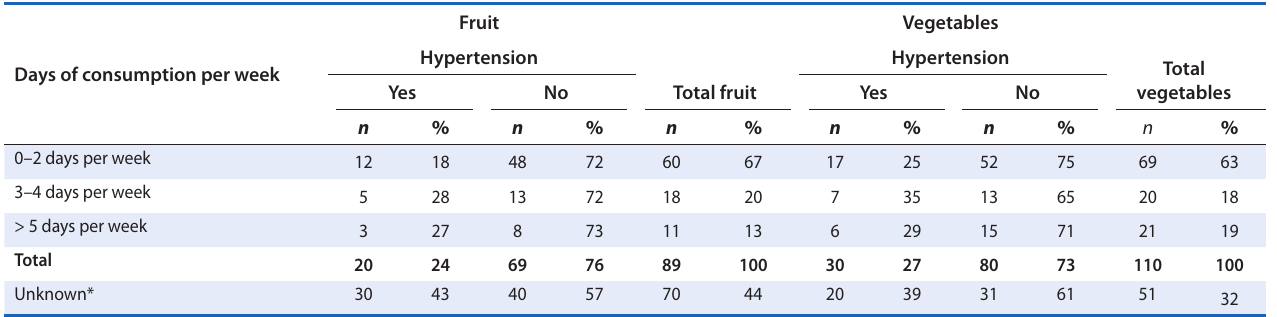
Table 2: Frequency of reported fruit and vegetable consumption by the Kang participants per occurrence of hypertension, Botswana, in 2008 Days of consumption per week